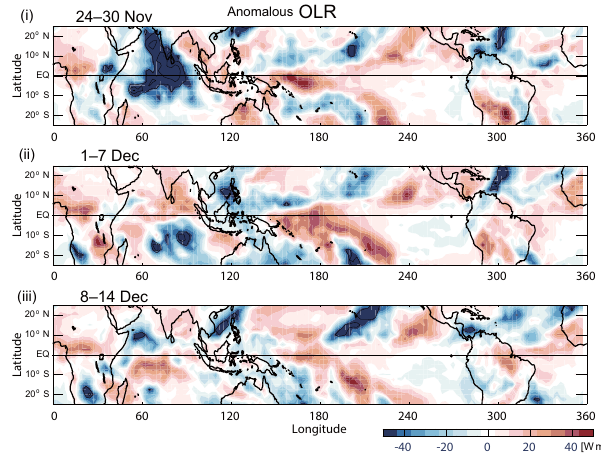
Figure 8. Same as Fig. 7 but for latitude–longitude sections of OLR anomalies.